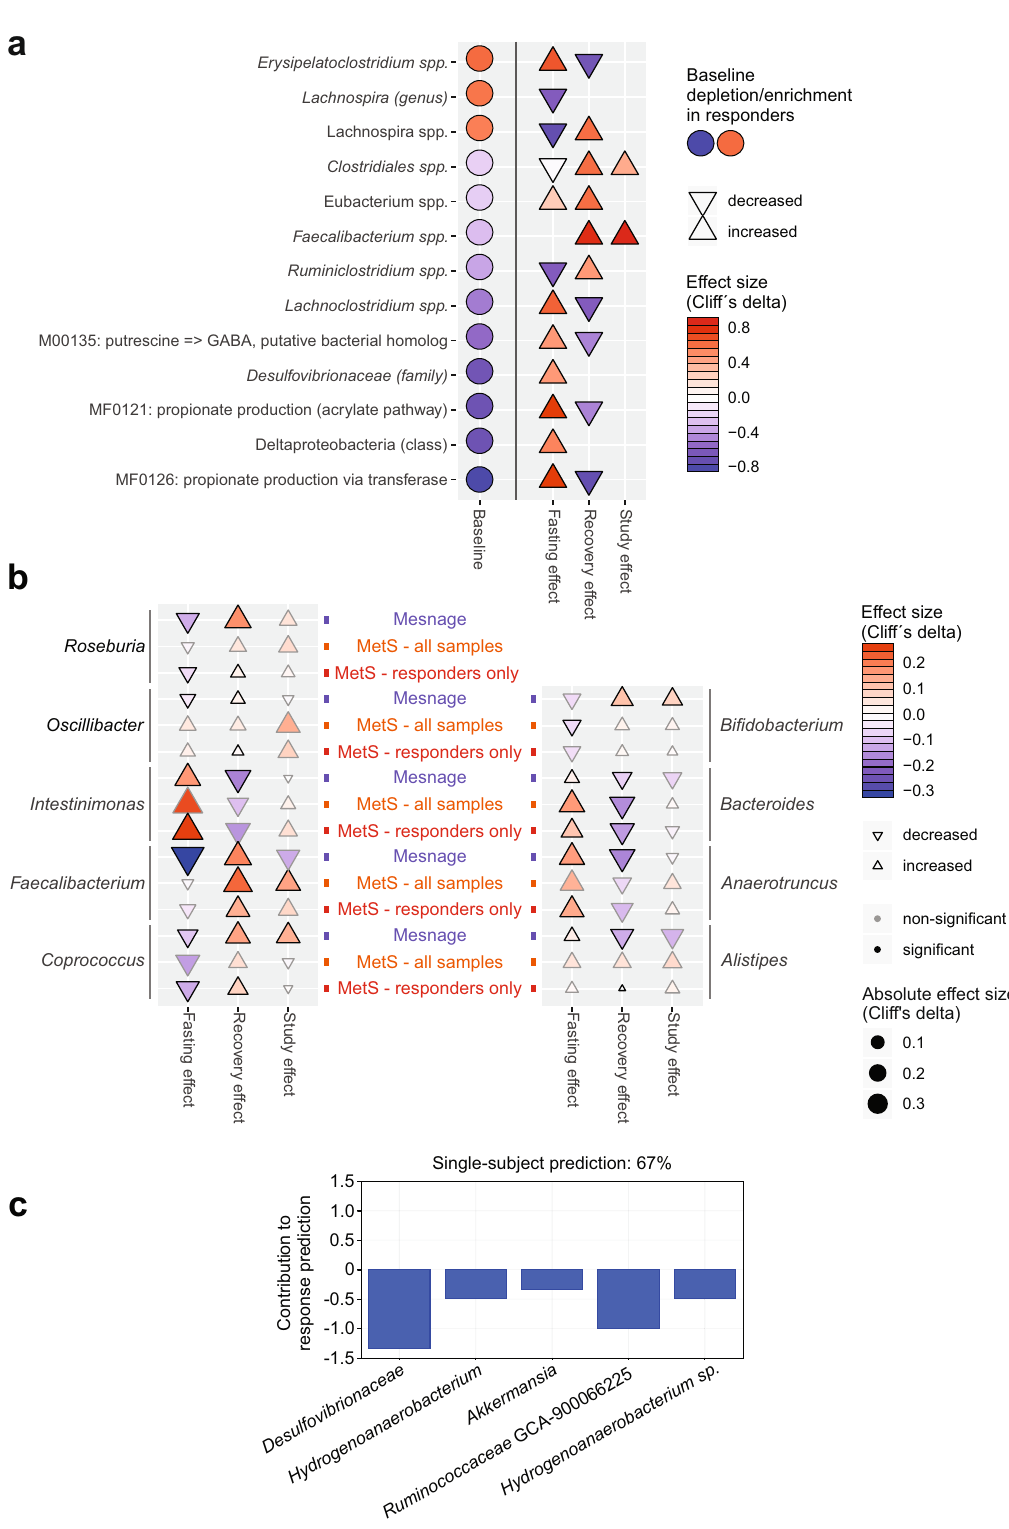
slightly higher in the fasting + DASH group compared to the DASH group (median 42%, 39%, respectively). Furthermore,